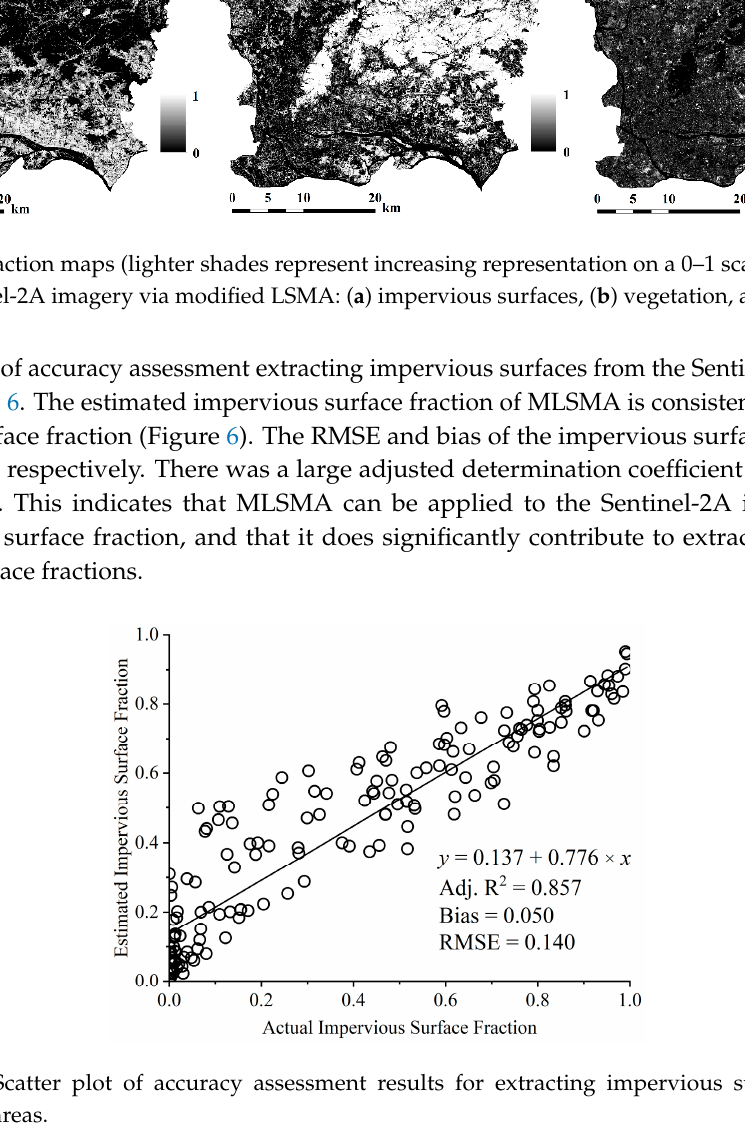
7 of 14 Figure 4. ( a ) Normalized difference built-up index (NDBI; warmer colors indicate a higher index); and ( b ) non-built-up (white) and built-up (red) areas extracted using Otsu’s method. Based on the built-up image extracted using Otsu’s method, MLSMA was applied to the Sentinel-2A image from 1 November 2017 to extract the impervious surface, vegetation, and soil fractions. The impervious surface, vegetation, and soil maps generated by MLSMA are shown in Figure 5. MLSMA performs well in extracting impervious surface fractions. Most pixels in the forested regions have a vegetation fraction of 100%, an impervious surface fraction of 0%, and a soil fraction of 0%. This is reasonable given that pixels in the forest region have a high vegetation fraction, along with a low impervious surface fraction or an impervious surface fraction of 0%. Figure 5 shows that impervious surface regions are largely found in Liwan, Yuexiu, Haizhu, Tianhe, southwest Baiyu, and south Huangpu while soil can be mainly found in the northeast part of the study area. However, in the built-up areas (Figure 4b), there is still soil fraction of greater than 0% (Figure 4c), which may be unreasonable. In the central urban areas, the land cover types, excluding water bodies, are mainly buildings, roads, and urban squares. Vegetation and bare soil can hardly be found in central urban